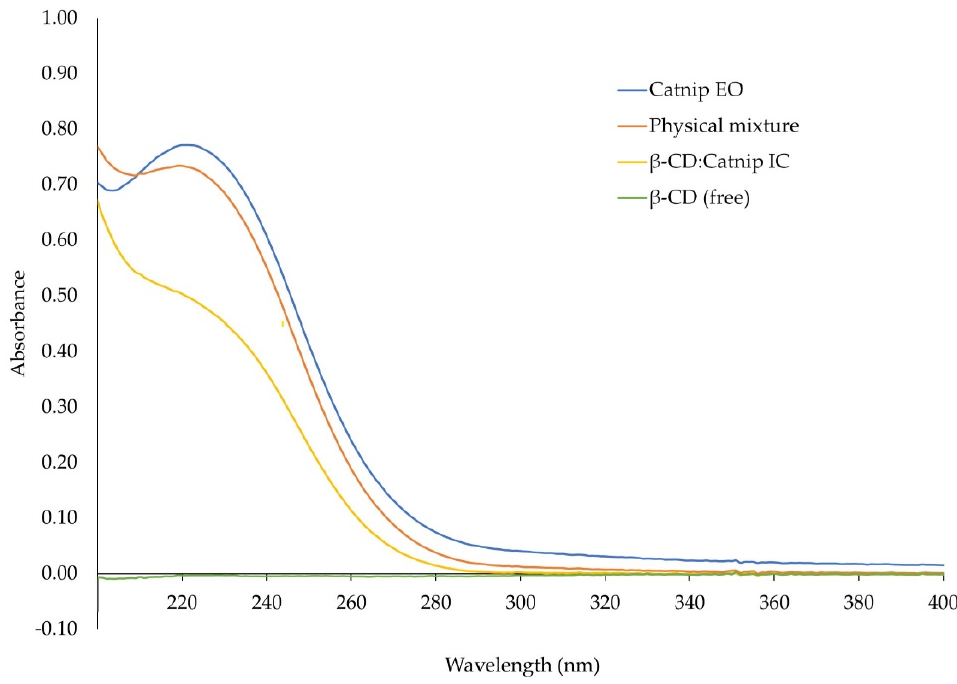
Figure 4. UV-Vis spectra of catnip essential oil (EO), β -cyclodextrin ( β -CD), their inclusion complexes (IC), and their physical mixture.